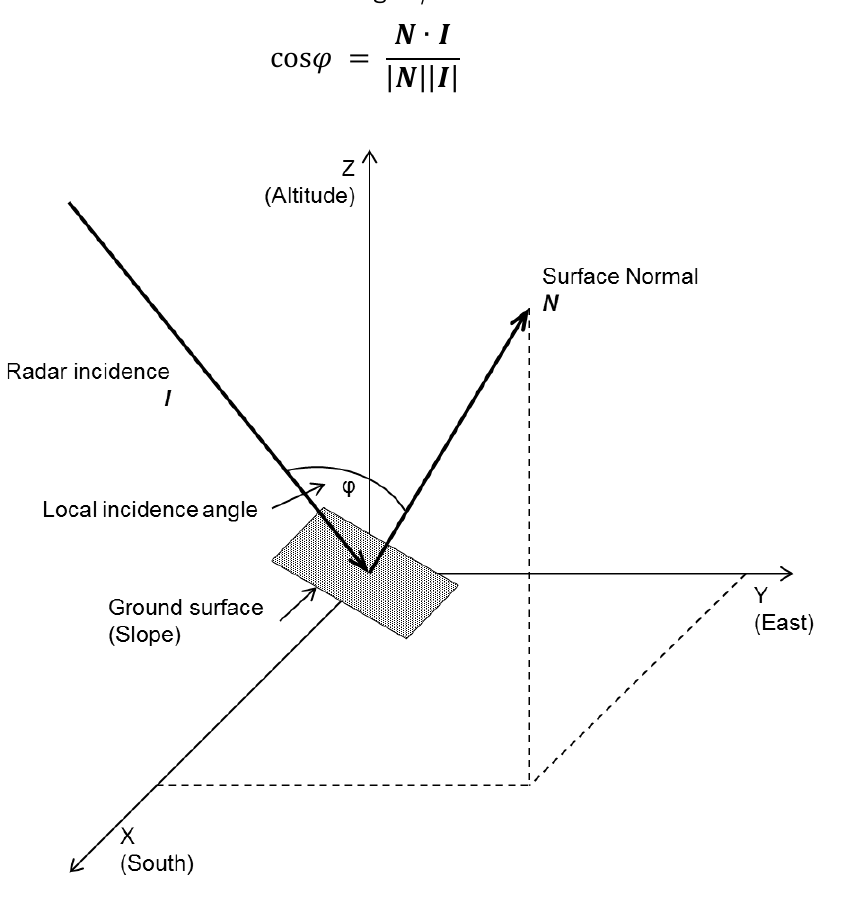
Figure 8. Schematic diagram of the radar observation geometry to relate the local incidence angle φ to the ground surface. The angle φ can be derived by the inner product of radar incidence direction N and ground surface normal I